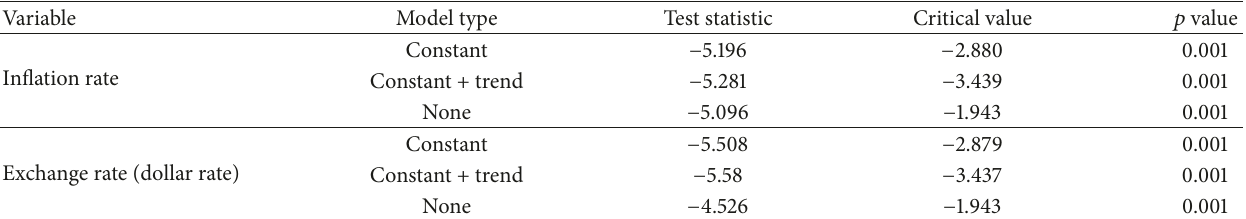
Table 2: Augmented Dickey-Fuller unit root test for the monthly rates of inflation and exchange rate (dollar rate) after first difference. Variable